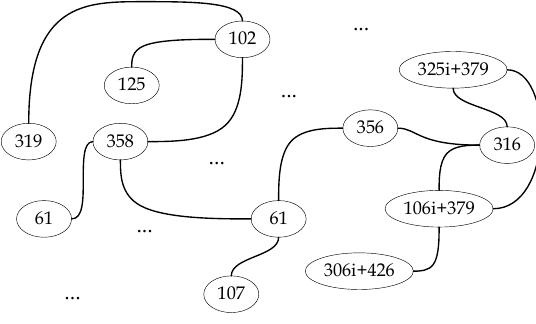
Figure 1. Portion of the 2-isogeny graph for p =